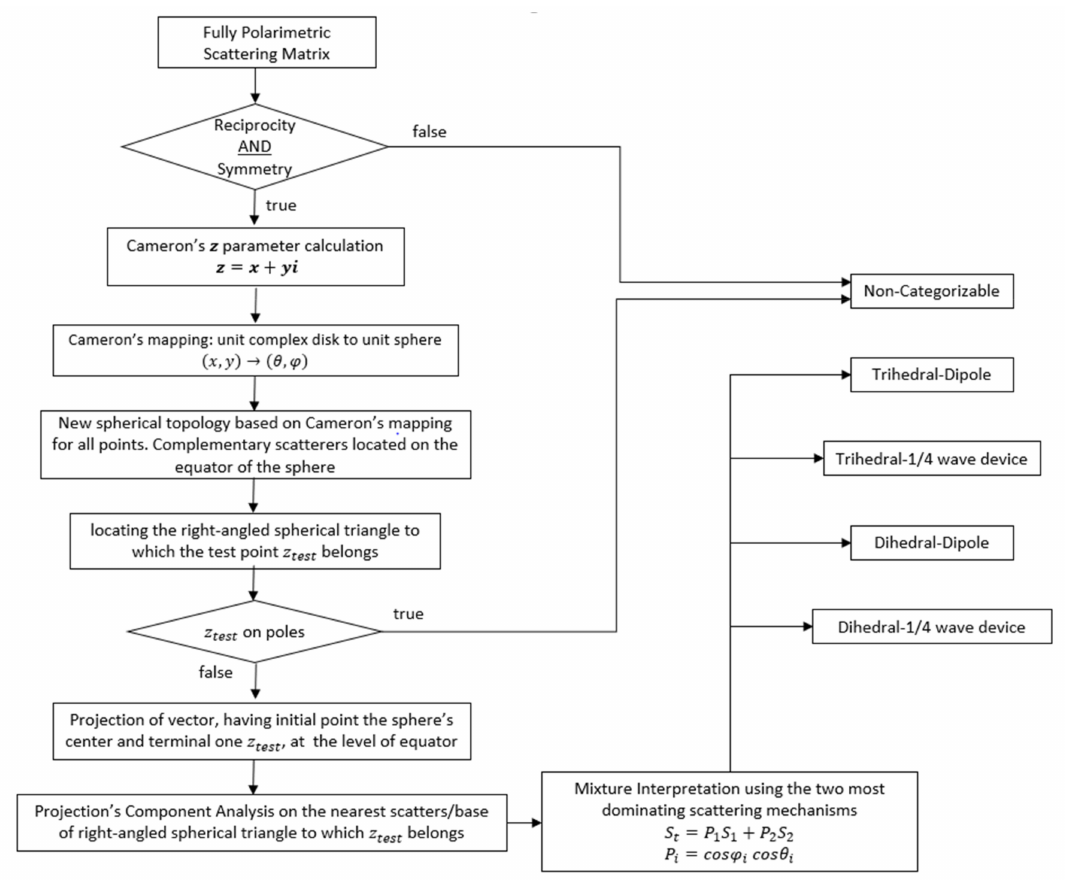
Figure 5. Block diagram of the proposed methodology followed to characterize the scattering properties of a SAR pixel by means of a pair of